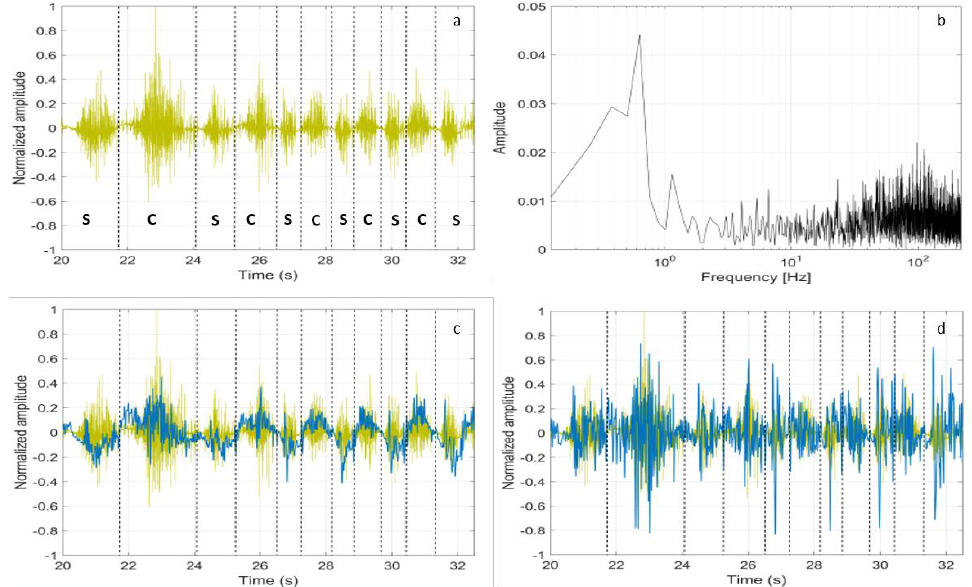
Figure 12. ( a ) Raw sEMG signal during a random stretching and contraction activity of the tibialis anterior recorded by our wearable device. The dashed trace defines the exact timing of stretching (s) and contraction (c); ( b ) FFT of the raw signal; ( c ) The blue trace is the low pass filtered sEMG signal (cutoff at 10 Hz); and, ( d ) The blue trace is the band pass filtered sEMG signal (3–10 Hz).